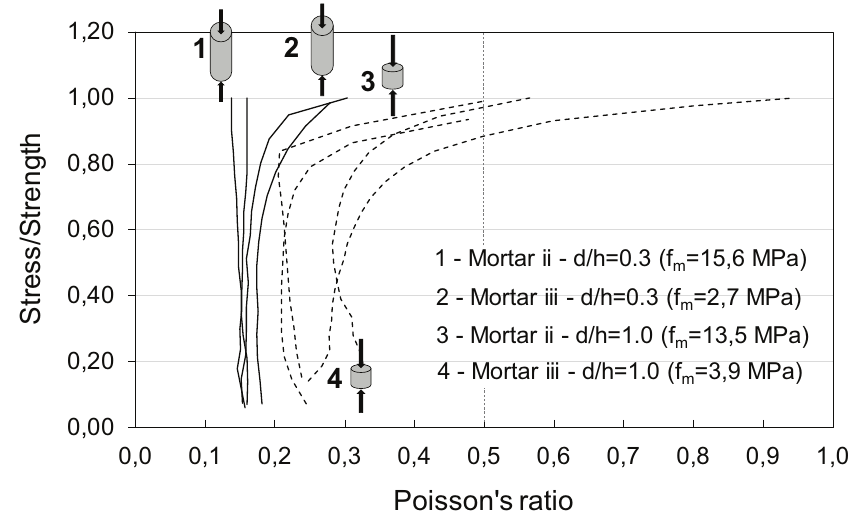
Figure 20 Stress/strength and apparent Poisson´s